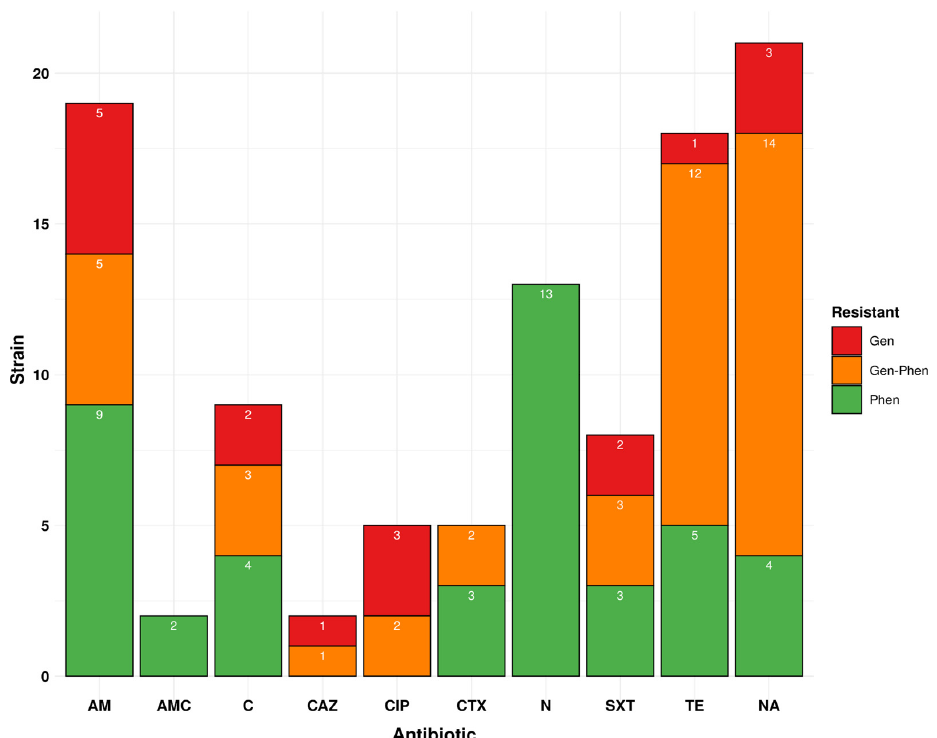
Figure 4. Individual antibiotic resistance profile of Peruvian isolates and their genotype–phenotype correlations for our ten tested antibiotics. Antibiotic abbreviation: ampicillin (AM), chloramphenicol (C), ciprofloxacin (CIP), trimethoprim-sulfamethoxazole (SXT), cefotaxime (CTX), nalidixic acid (NA), amoxicillin-clavulanate (AMC), nitrofurantoin (N), tetracycline (TE), and ceftazidime (CAZ). AMR profile abbreviation: Gen, genotypic; Phen, phenotypic; Gen-Phen, genotypic-phenotypic. 3.5. Genotypic Profile Showed 31.0% of Drug Resistance Isolates Are Circulating in Peru